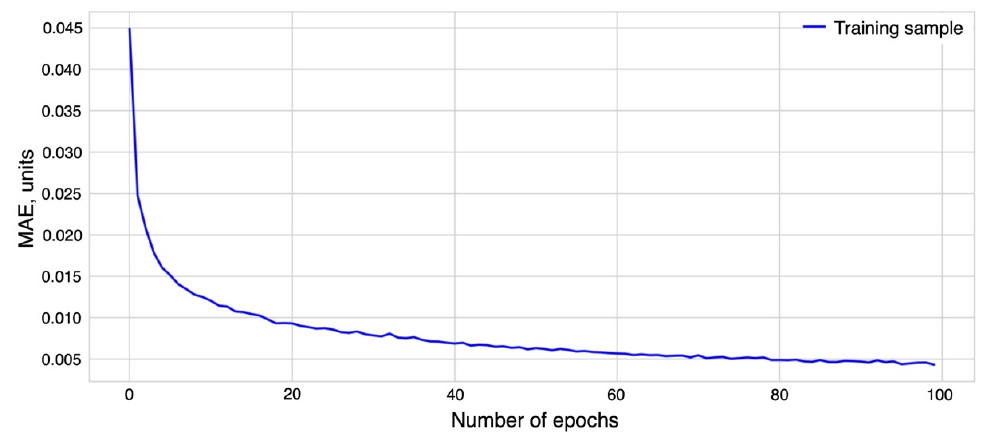
Figure 9. Model training.